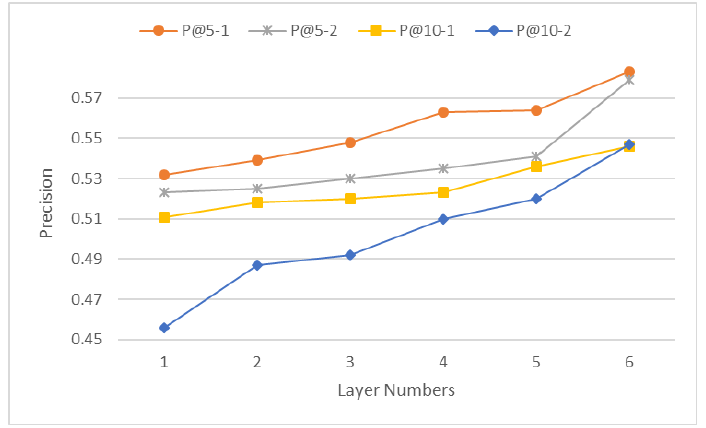
Figure 7. Precision generated by models with different numbers of